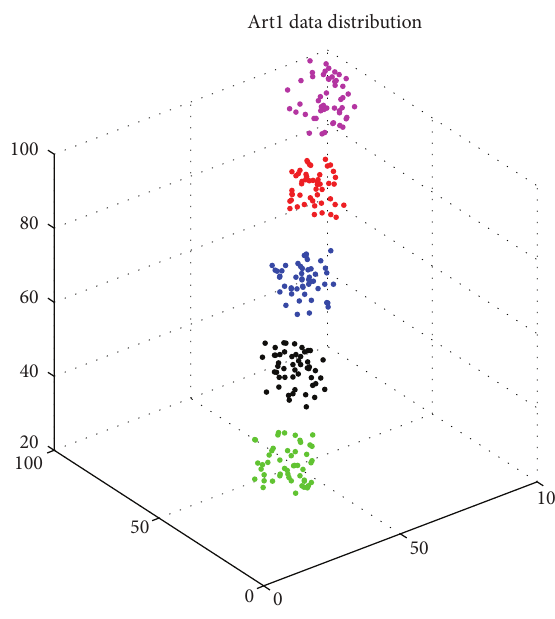
Figure 4: The distribution image of Art1.